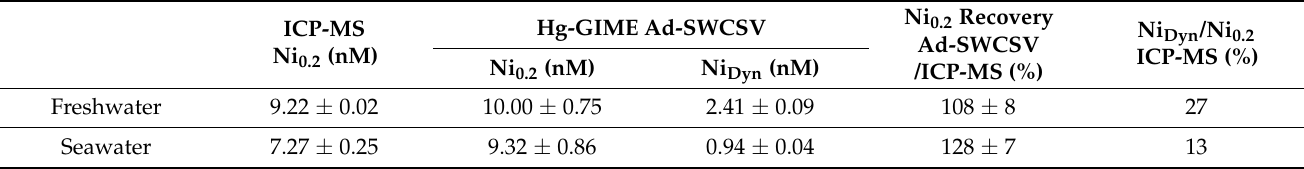
Table 2. Intercomparison of ICP-MS total dissolved Ni(II) and Hg-GIME Ad-SWCSV total dissolved Ni(II) and dynamic Ni-nioxime